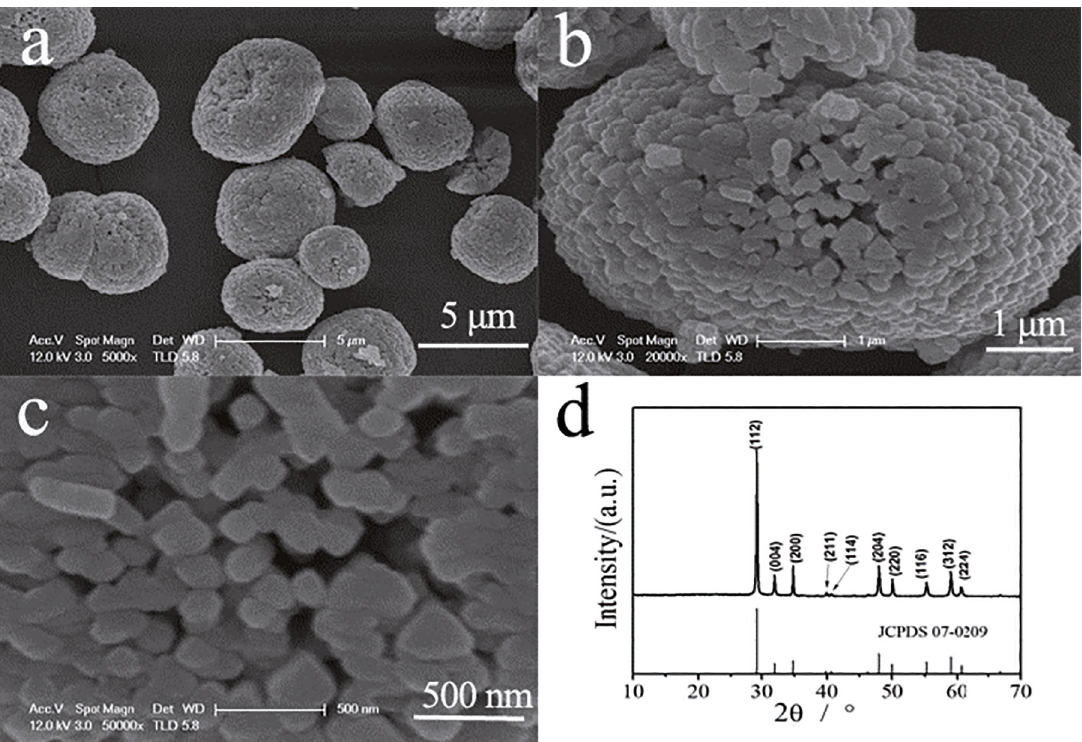
products obtained at pH=5.00, 180 4